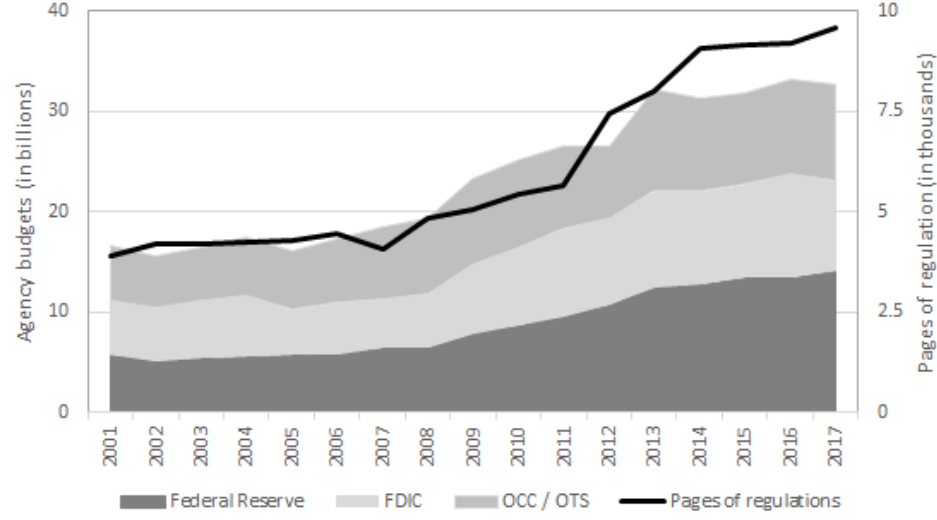
Figure 3. Budgets of the primary bank regulators and pages in CFR Title XII on Banks and Banking. Sources: Data from Code of Federal Regulations and Regulators’ Budget